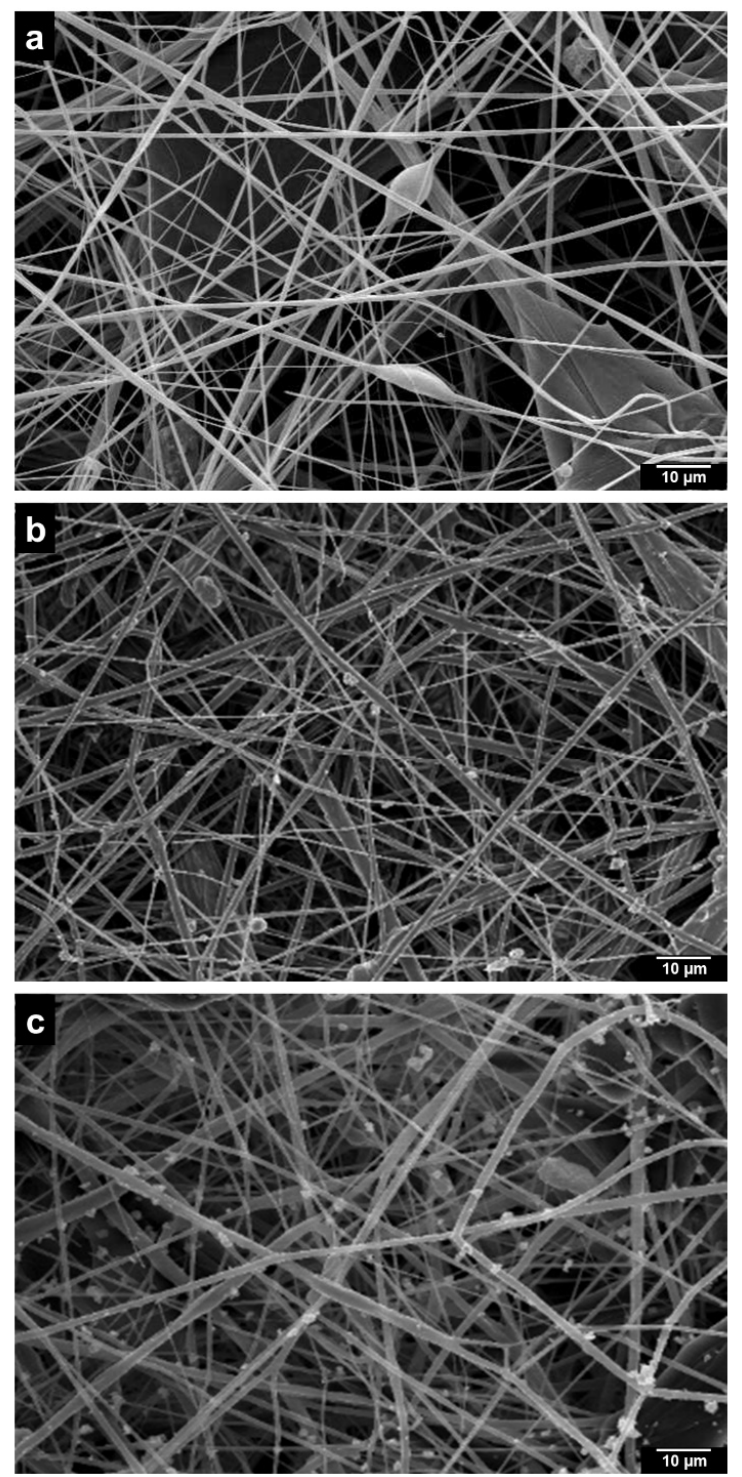
Figure 2. Scanning electron microscopy assessment of the microstructure of the polylactic acid (PLA) scaffolds loaded with different concentrations of zirconium oxide nanoparticles (ZrO 2 ). ( a ) PLA scaffolds synthesized with the air-jet spinning technique. ( b ) PLA scaffold loaded with 0.1 g of ZrO 2 . ( c ) PLA scaffold loaded with 0.5 g of ZrO 2 . The PLA/ZrO 2 scaffolds show dispersed and unsaturated ZrO 2 nanoparticles along the PLA fibers, scale bar = 10 µm.